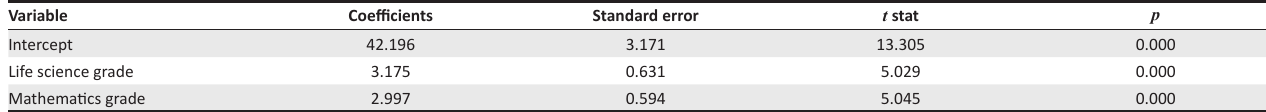
TABLE 5: Multiple regression model summary predicting grade for first year science modules.